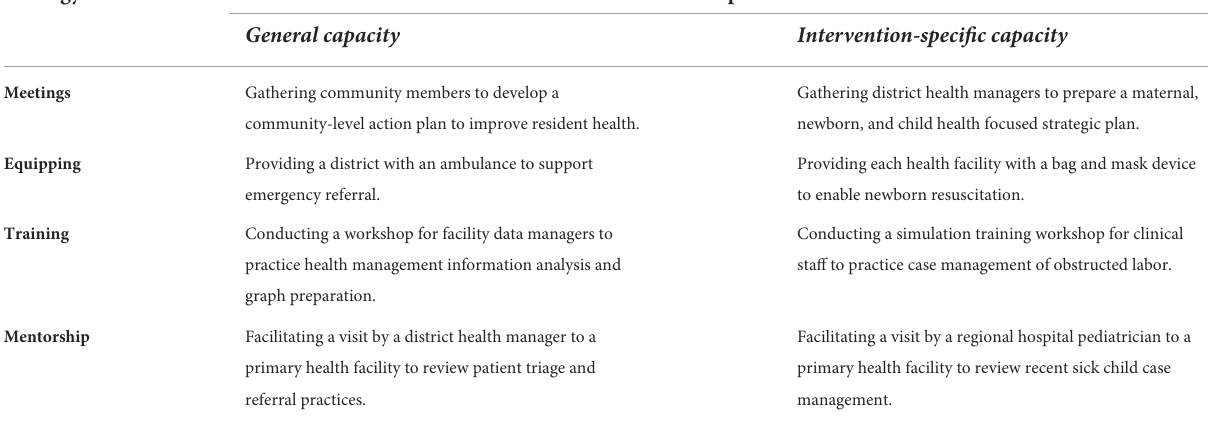
TABLE 2 MERI change strategy activity examples: General and intervention-specific